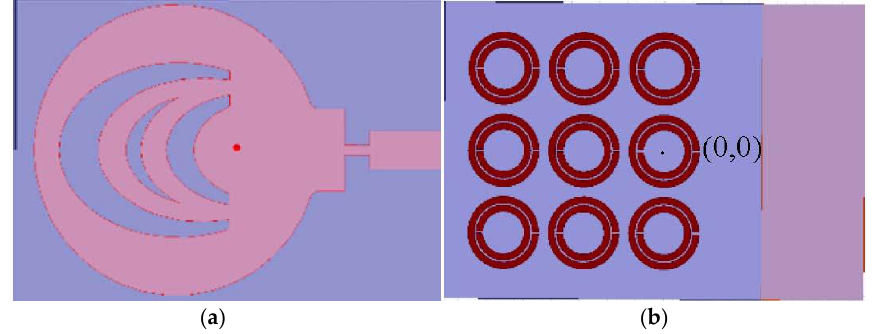
Figure 22. ( a ) Antenna front side ( b ) antenna back.